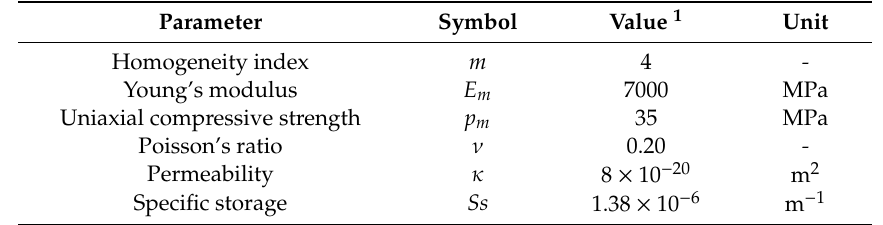
Table 2. Material parameters of oil-bearing layers of the multilayered numerical model in RFPA-Petrol. Parameter